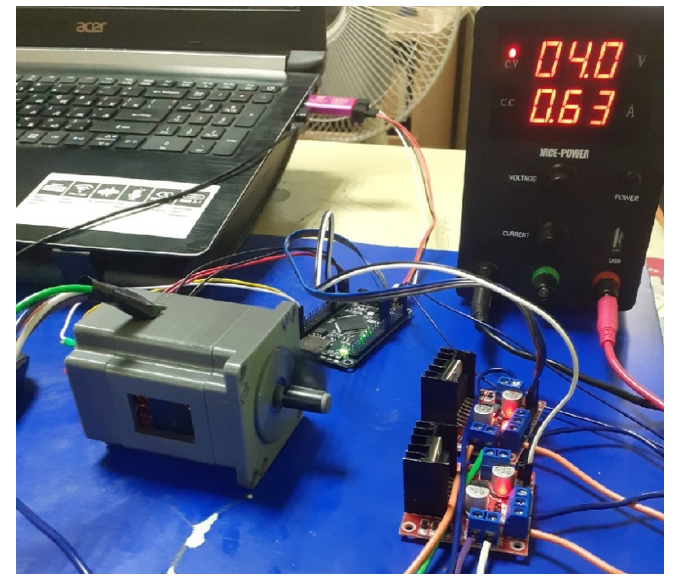
Figure 14. The prototype of motor.